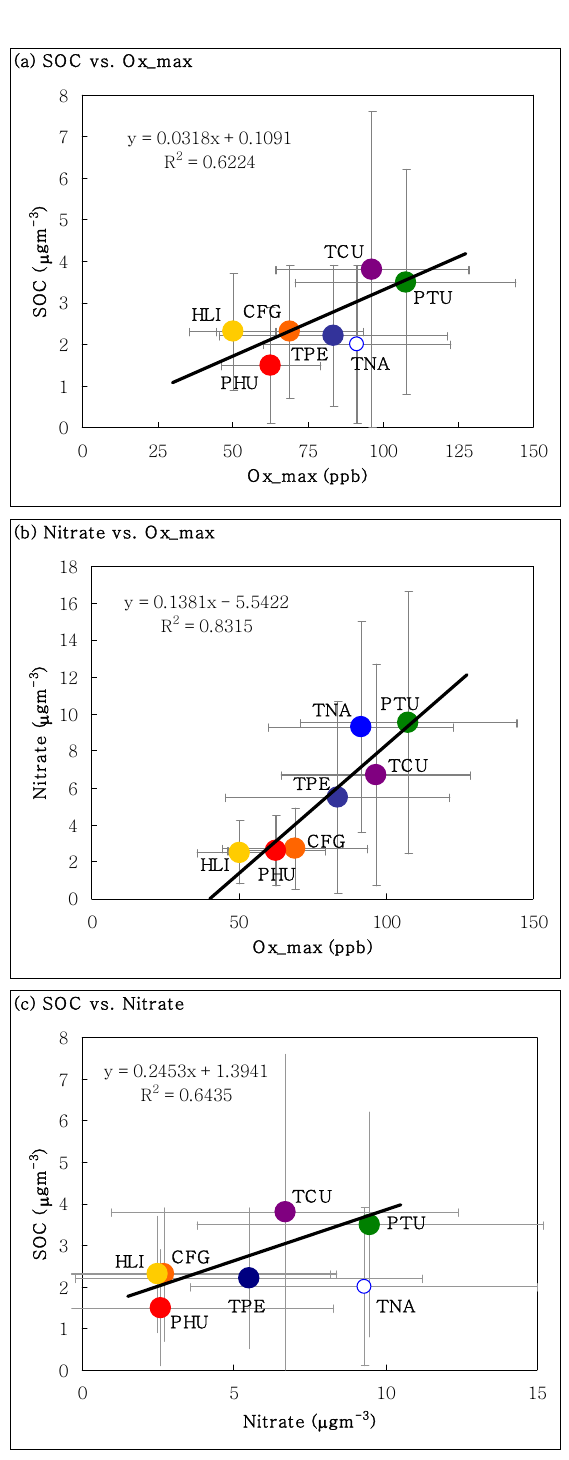
Fig. 8. Correlations between SOC and Ox max (a) , between partic- ulate nitrate and Ox max (b) , and between SOC and NO x (c) across the network stations. The color coding of symbols are consistent with Fig. 7. The data of the Tainan station were treated as outliers in the linear regression processes and hence are shown as open sym- bols in panels (a) and